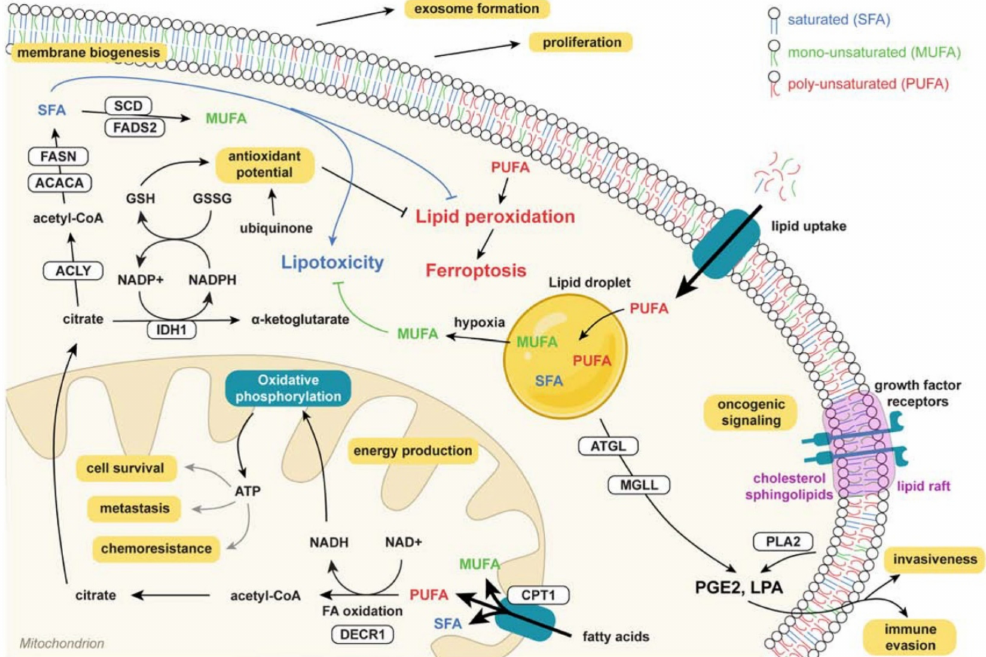
Figure 3. Role of lipids in cancer biology. Cancer cells are dependent on fatty acid synthesis for membrane biogenesis during cell proliferation. Their oxidation generates ATP and increases antioxidant potential through glutathione synthesis. Additionally, they participate in cell signaling mechanisms. To prevent the peroxidation of polyunsaturated fatty acids, tumoral cells store this type of lipids or catabolize them via Fas oxidation pathways. Image republished from [28] with permission from Elsevier. Copyright ©